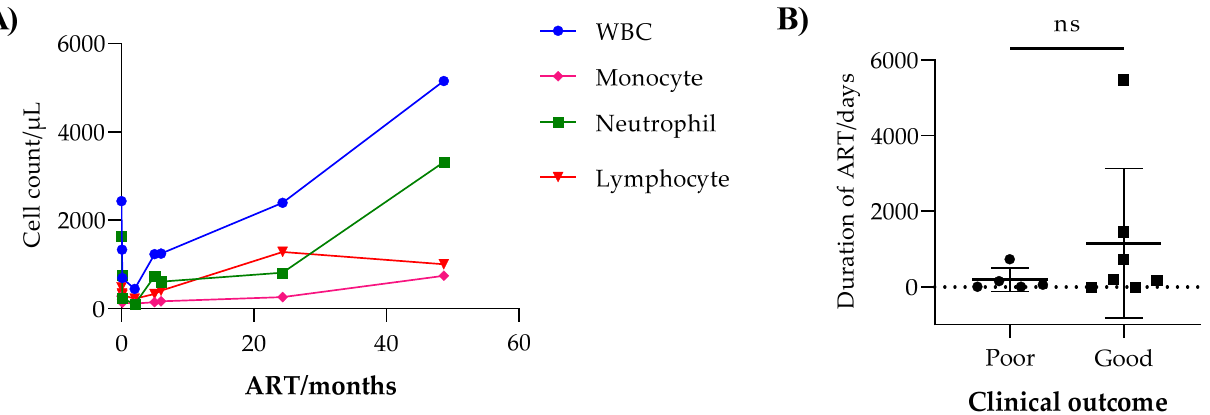
Figure 2. ( A ) White blood cell (WBC) and platelet count, ( B ) clinical chemistry test results among VL patients with and without HIV coinfection. * 10, the presented cell count value should be multiplied by 10 to obtain the actual cell count.